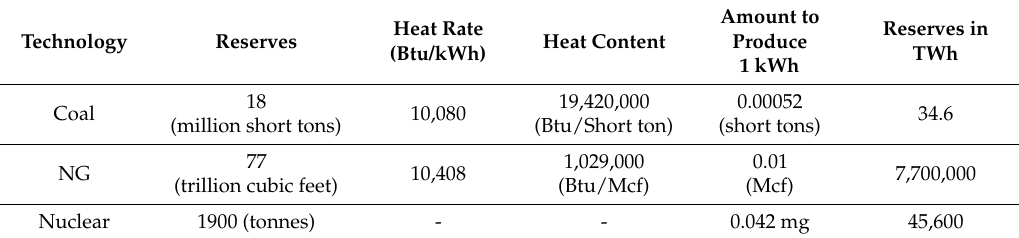
Table 2. Energy conversion data for coal, natural gas and nuclear [50–54].